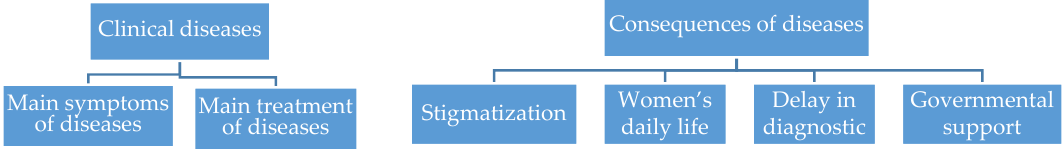
Figure 1 synthetizes this table’s data: